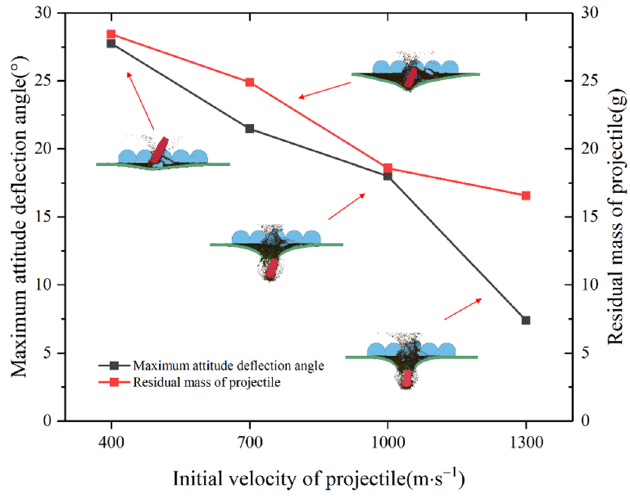
Figure 23. Maximum attitude deflection angle and residual mass of projectile under different initial velocities.